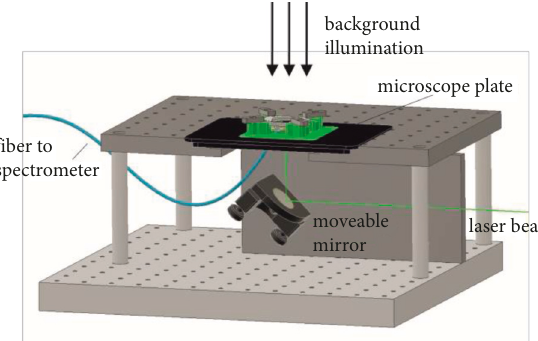
Figure 3: Drawing of the analytical set-up. On the left is a mi- croscope plate with the chip holder to be described in Figure 4. A fiber of a spectrometer is attached underneath. The OEW light from a laser diode at a wavelength of 520nm is regulated with a neutral density filter to a power of 150 nW and enters the set-up from the bottom directed via moveable mirrors.